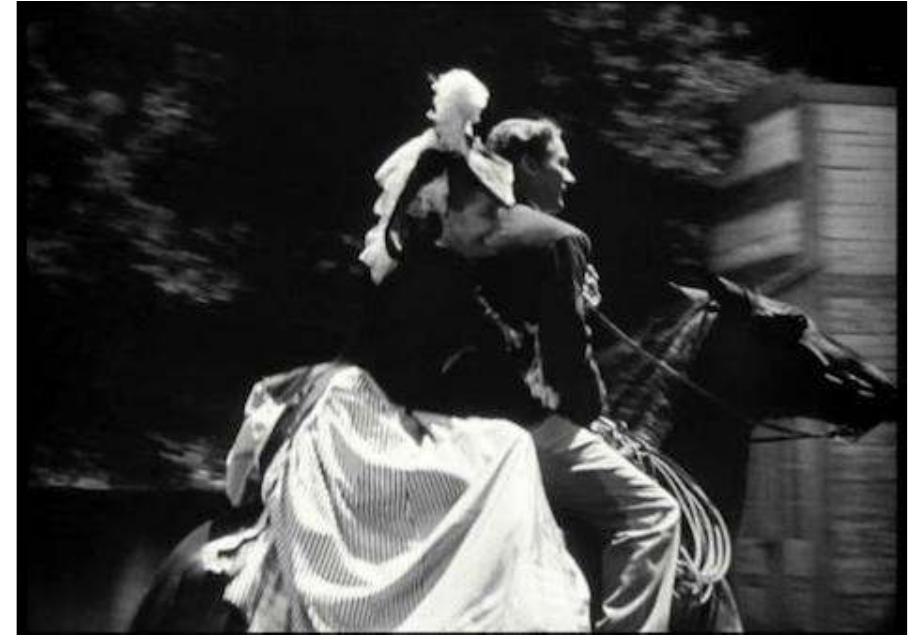
Figure 26: Georgia sitting side-saddle behind Mike in Silver